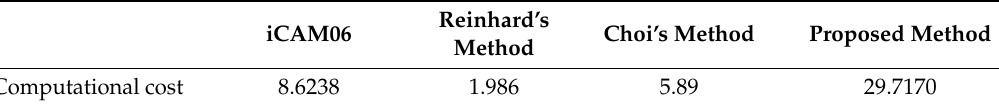
Table 1. Comparative evaluation of computational cost between iCAM06, Reinhard’s method, Choi’s method, and the proposed method (units: per